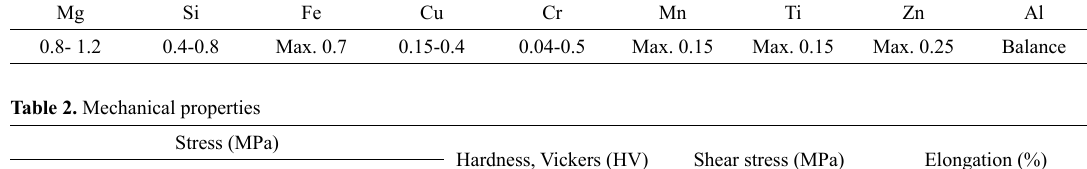
Table 1. Chemical composition